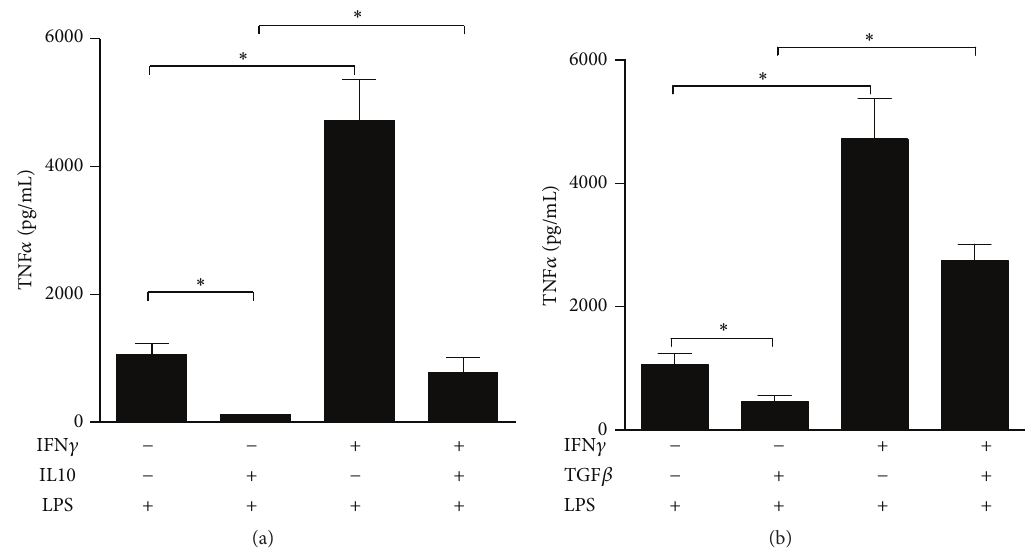
Figure 4: Inhibitory role of IFN 𝛾 on IL-10- and TGF 𝛽 -dependent endotoxin tolerance . Monocytes were pretreated or not with 10 ng/mL IFN 𝛾 and primed with 10ng/mL IL-10 (a) or 50ng/mL TGF 𝛽 (b) for 18h and then stimulated with 10ng/mL LPS. Supernatants were collected 24 h later; TNF 𝛼 protein levels were quantified by ELISA. Results are expressed as mean ± SEM of three independent